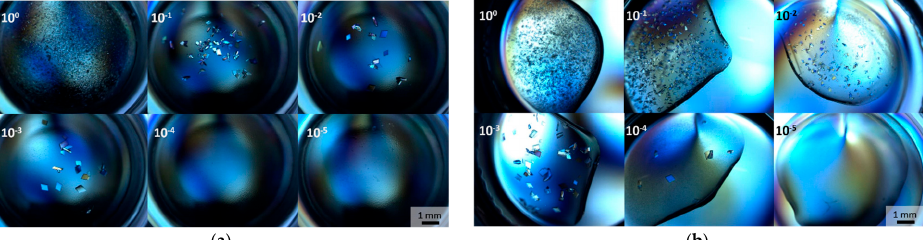
Figure 4. The effect of diluting and testing the seed stock solution. Crystallization drops were set up in 0.1 M Tris pH 8.5, 30% PEG 4000, 0.2 M sodium acetate in a ratio of 3:2:1 (protein:precipitant:seeds) in ( a ) vapor diffusion sitting drop set-up (total drop volume is 24 μ L) and ( b ) microbatch with paraffin